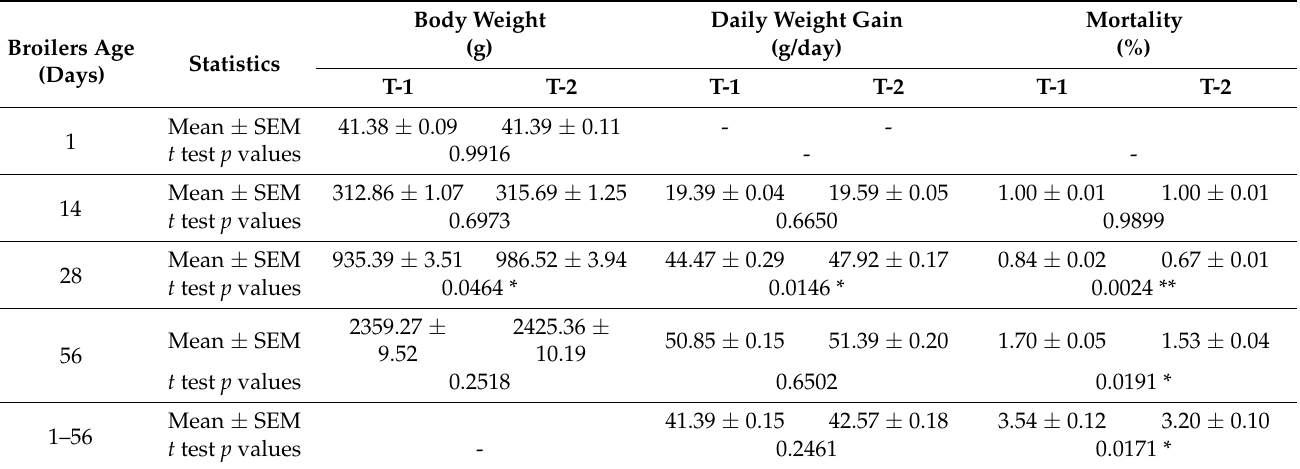
Table 3. Dynamics of body weight, daily weight gain, and